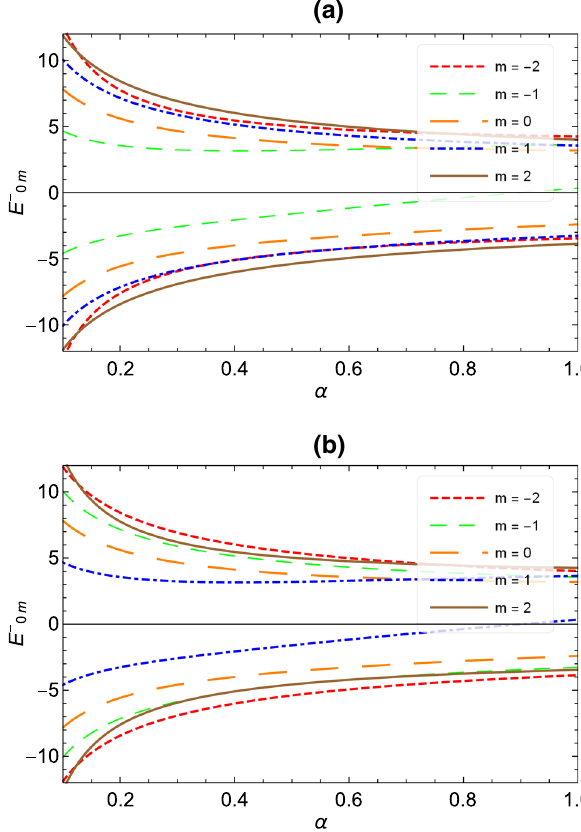
Fig. 1 Illustrationoftheenergyeigenvaluesinthespinsymmetrylimit, E + , as a function of the parameter α . (a) s = 1 and (b) s = − 1. We use 0 m M = 1, η C = 1 and η L = 1. In a the energies of the states with m < 1 becomelargerfor α → 0whereasfor α = 1thedifferencesbetweenthe energy levels decrease as well as the energy values. For the states with m (cid:2) 1 (dot-dashed blue and solid brown lines), the energies change very slowly and are non-degenerate. In b the opposite of a occurs: the states with m (cid:2) 0 are more energetic for α → 0 and less energetic for α = 1